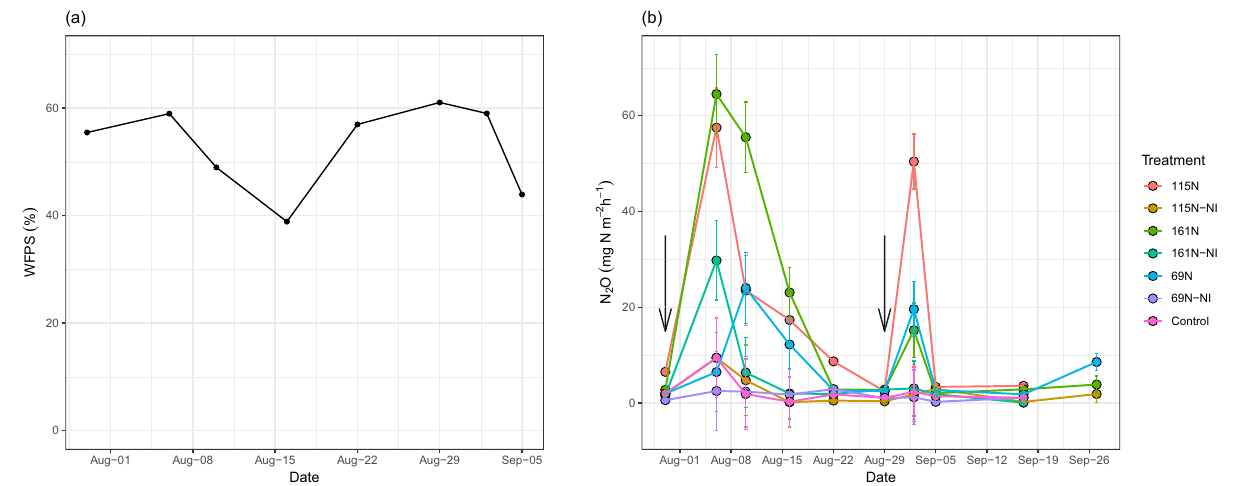
Figure 1. Temporal variations of soil water-filled pore space (WFPS) ( a ) and N 2 O emission ( b ) in the different levels of N application and with or without NI during the maize growth season in 2018. Vertical bars indicate the least significant difference (LSD) amount at p < 0.01, n = 3. Arrows denote time of N